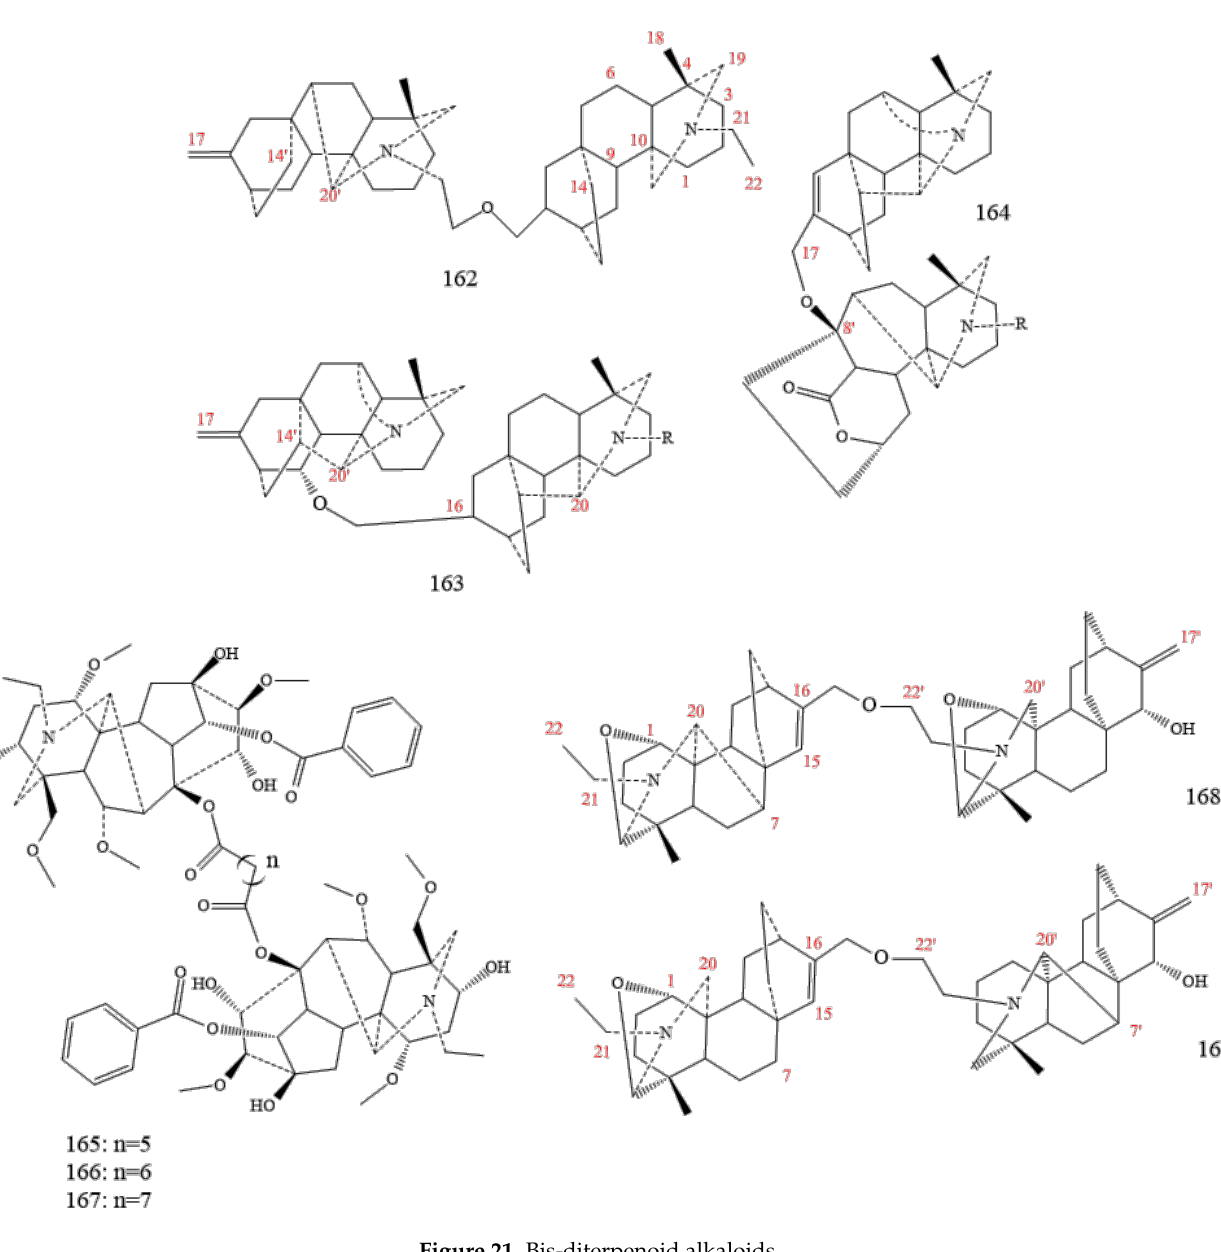
Figure 21. Bis-diterpenoid alkaloids.